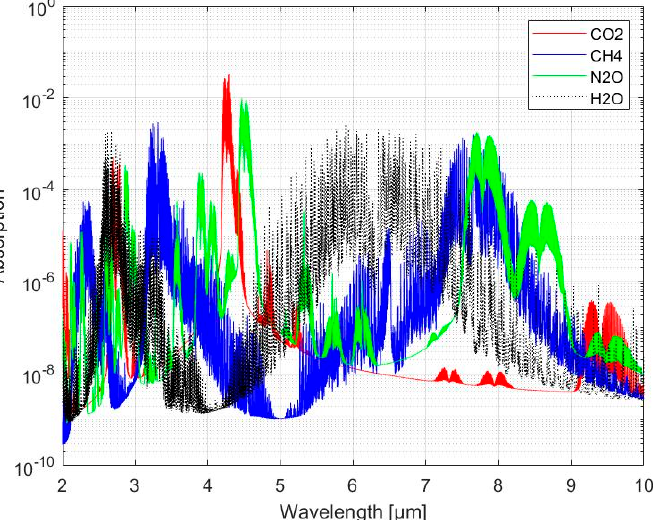
Figure 1. Absorption bands of carbon dioxide (CO 2 ), methane (CH 4 ), nitrous oxide (N 2 O) and water vapor (H 2 O). Spectra are simulated using data from HITRAN (http://hitran.iao.ru/ accessed on 13 March 2022) for an optical length of 1 m and gas species mole fractions set to 1 ppm.